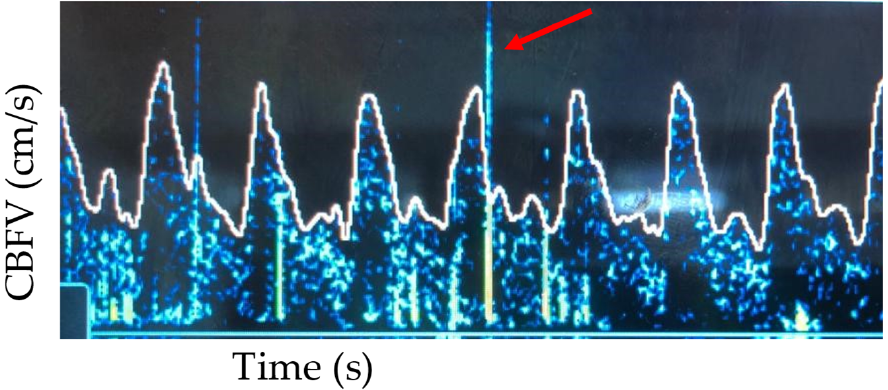
Figure 5. Multiple examples of HITS detected (red arrow for a singular example).